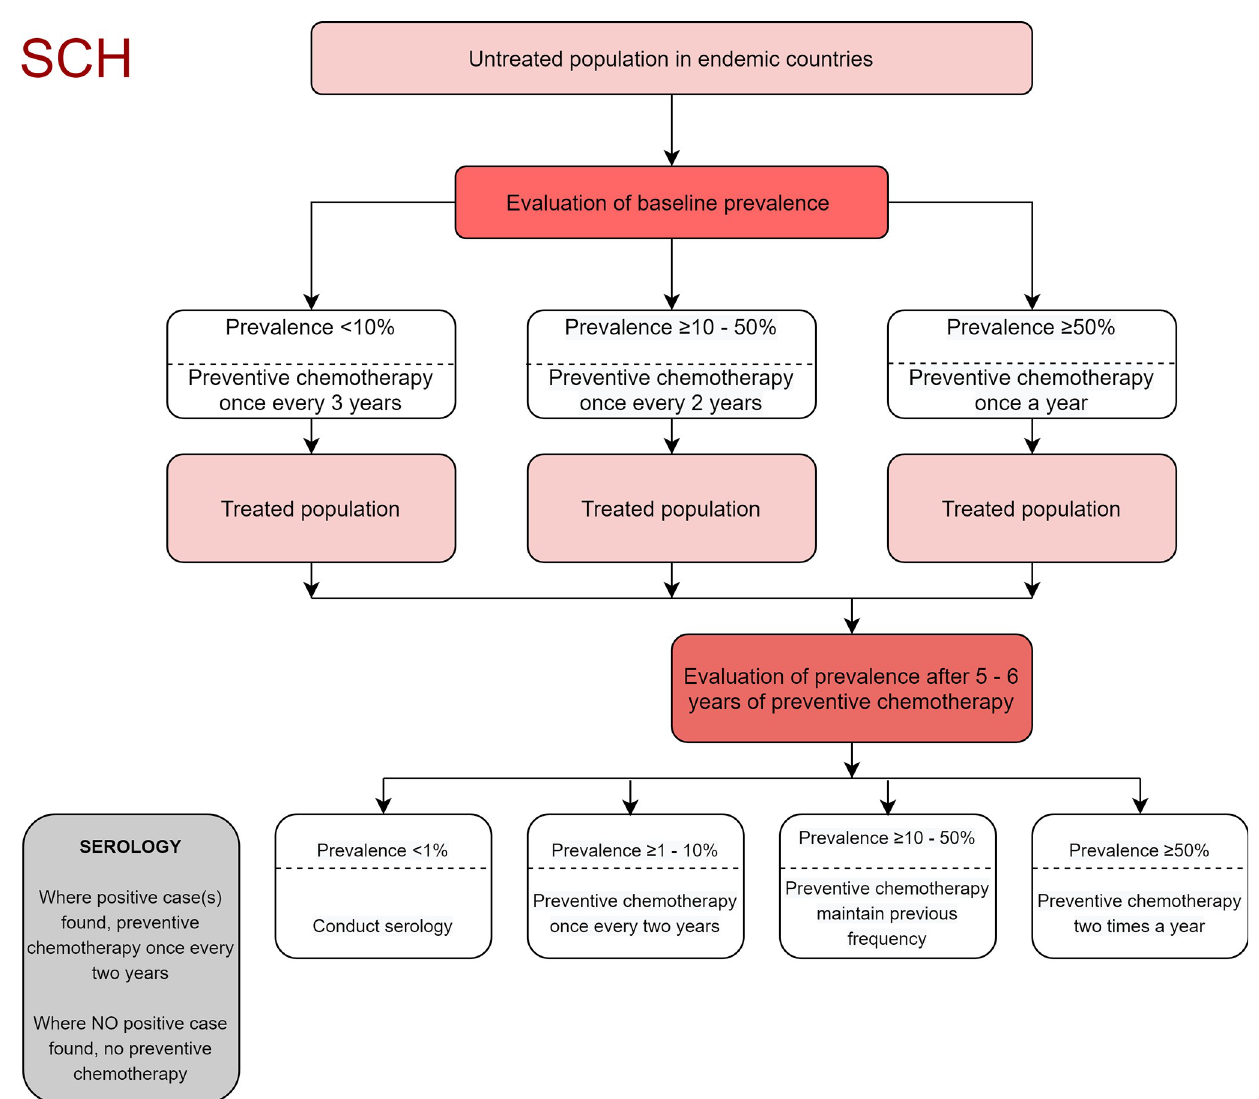
Fig 5. WHO guidelines decision tree for Schistosomiasis after five to six years of deworming.